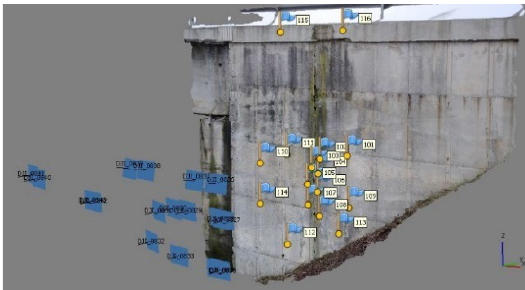
Figure 11 . Reference photogrammetric model of the bridge abutment built by Agisoft Metashape. Blue rectangles are the oriented cameras, while the flags denote the